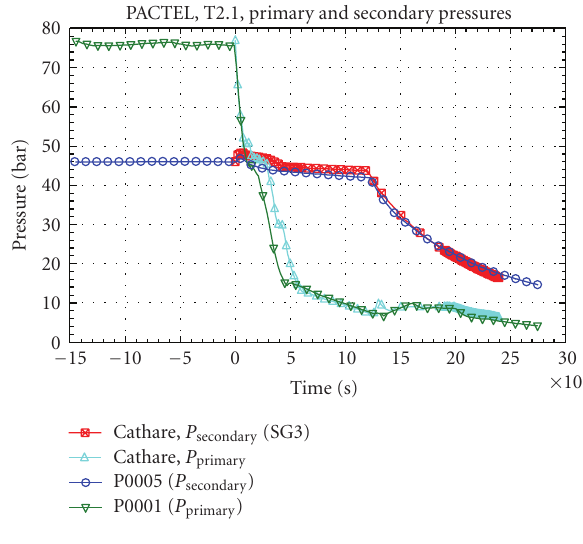
Figure 4: Primary and secondary pressures.